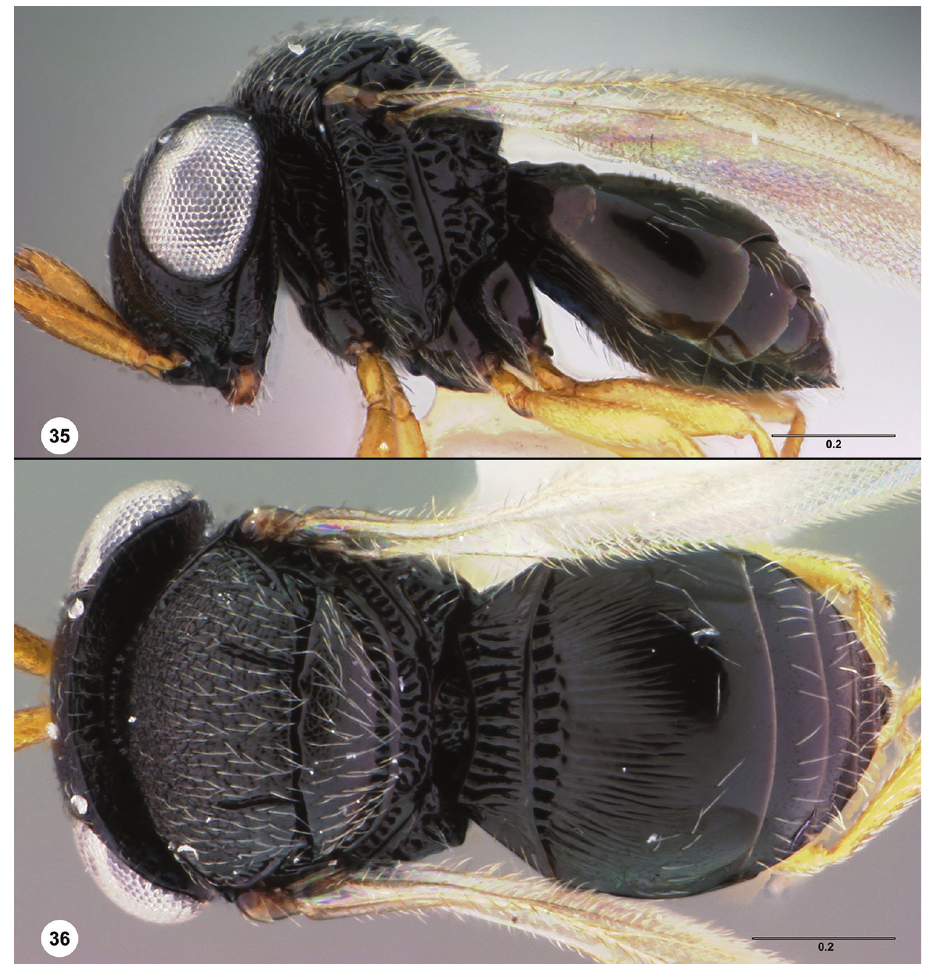
soma, lateral view 36 head, mesosoma, metasoma, dorsal view. Scale bars in millimeters.